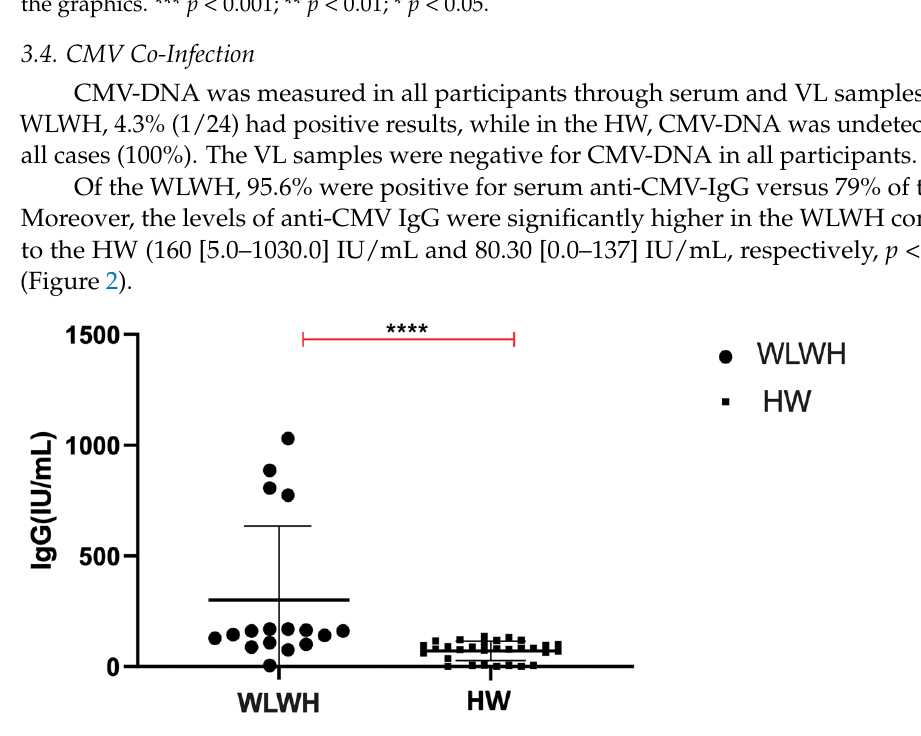
Figure 2. Quantitative dosage of anti CMV-IgG levels in WLWH and HW. The differences were evaluated using the nonparametric Mann–Whitney test. Data are shown as median (lines). Statistical significance ( p ) is reported in the graphics. **** p <